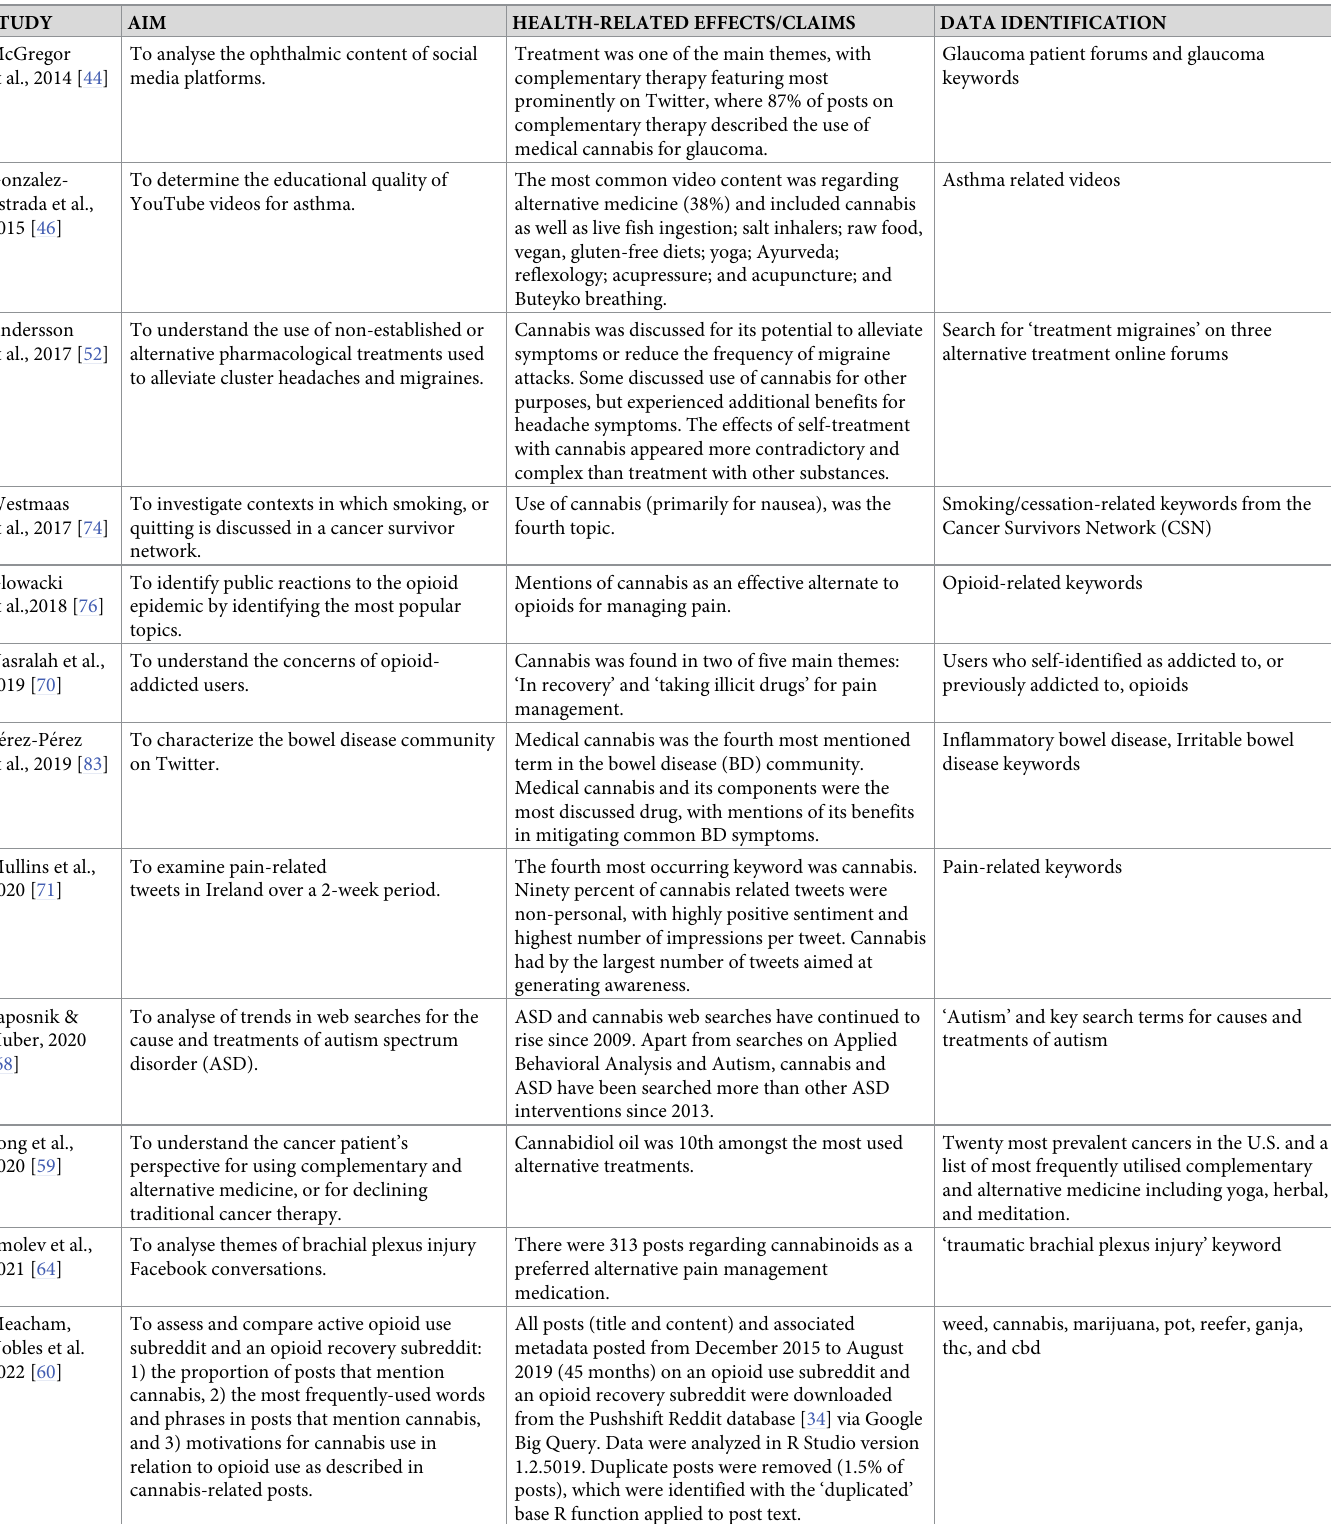
Table 7. Cannabis as a medicine as part of discourse on illness and